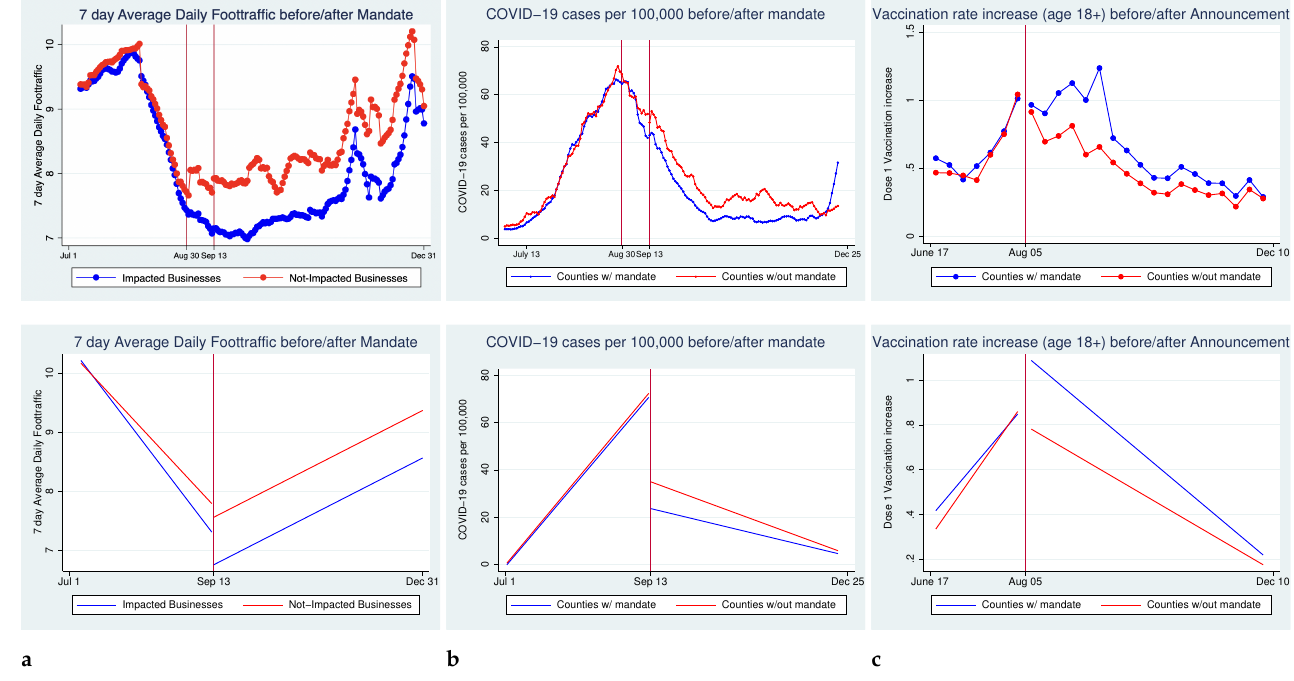
Figure 1. Pre- and post- mandates values and fitted trends for impacted and non-impacted busi- nesses or counties. ( a ) 7-day rolling average foot traffic before and after implementation of the mandates, by businesses impacted or not. ( b ) 7-day rolling average of new COVID-19 cases per 100,000 individuals before and after implementation of the mandates, by counties with or without mandates. ( c ) Increase in county vaccination rates of the first dose administered weekly for all adults before and after the announcement of the mandates, by counties with or without